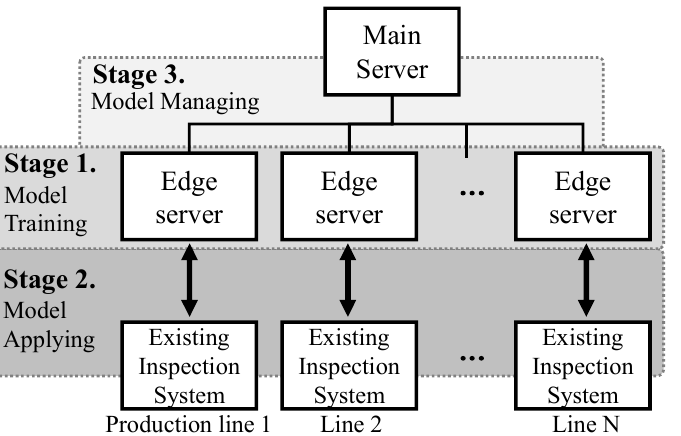
Figure 1. System hierarchy for automatic product inspection via deep learning and proposed three stages for the